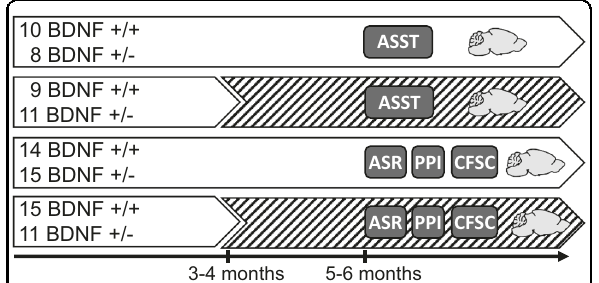
Fig. 1 Experimental procedure. On the left, the group sizes and genotypes of the different batches of mice are given. White background indicates standard housing, hatched background enriched environment housing. On the bottom, the timelines of the experiment are shown. Experimental tests: ASST attentional set- shifting task, ASR acoustic startle response, PPI prepulse inhibition, CFSC contextual fear and safety conditioning. The brain symbol indicates the brain dissection after the end of the behavioral